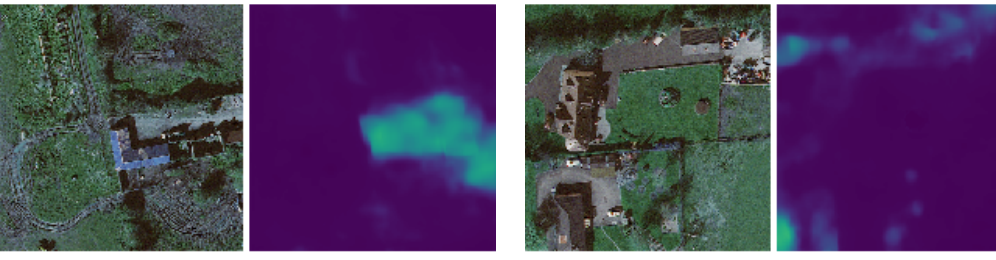
Figure 15. Examples of poor performance of DSM estimation on sparse